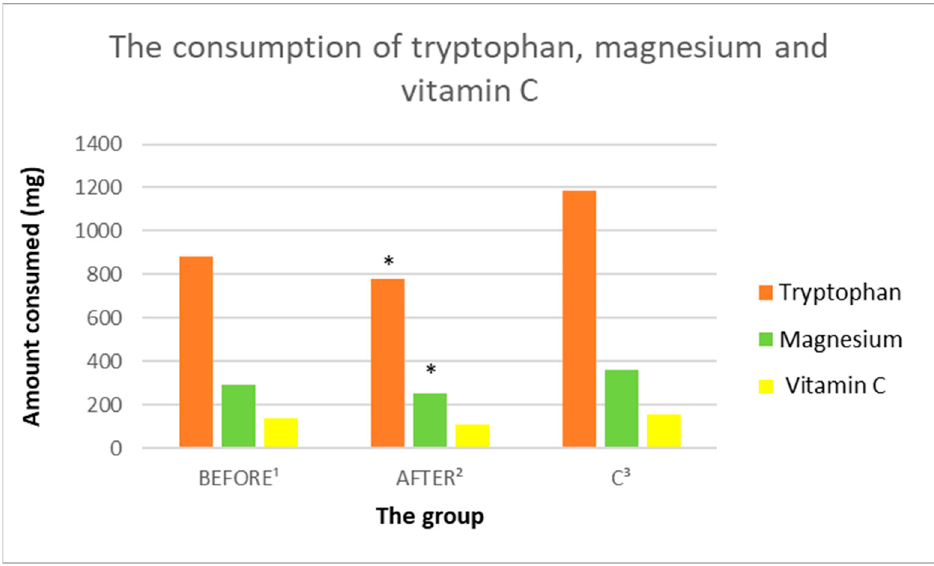
Figure 10. Average daily intake of tryptophan, magnesium, and vitamin C by groups. ¹ study group prior to ketamine administration; ² study group after administration of ketamine; ³ control group; * indicates a statistically significant result p < 0.05 in the group after administration of ketamine, compared to the control group.